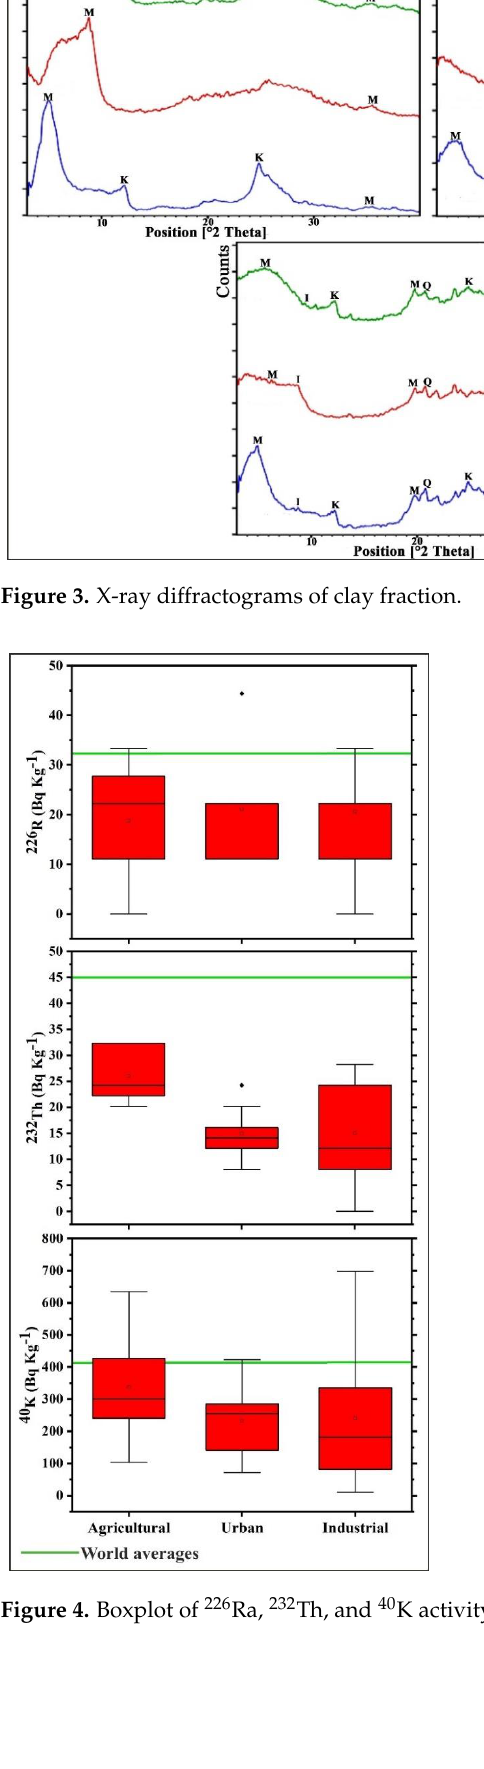
industrial complexes.